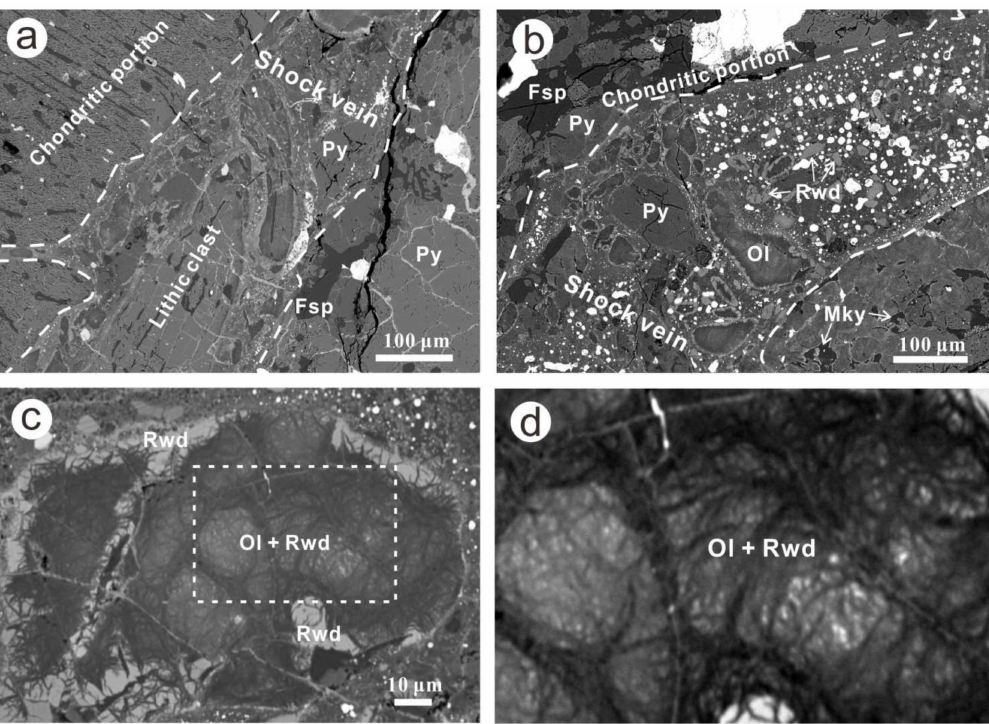
Figure 3. ( a ) Two lithic clasts in the shock vein. The chondritic portion mainly consists of olivine, pyroxene, feldspar, Fe-Ni metal, and troilite. ( b ) Shocked olivine clasts in the shock vein generally have a ringwoodite rim. The white spherules in the shock vein are Fi-Ni metal and troilite. Note the maskelynite grain adjacent to the shock vein. ( c ) An olivine-ringwoodite clast with ringwoodite rim and olivine core. ( d ) High magnification image of the ( c ). The central region of the clast has a complex structure that consists of olivine and ringwoodite. Fsp—feldspar, Py—pyroxene, Ol—olivine, Mky—maskelynite, Rwd—ringwoodite. Table 1. Representative electron microprobe analyses of olivine-ringwoodite fragments and maskelynite in the shock vein and host olivine grains in the chondritic portion. Ol-Rwd Fragment Oxide